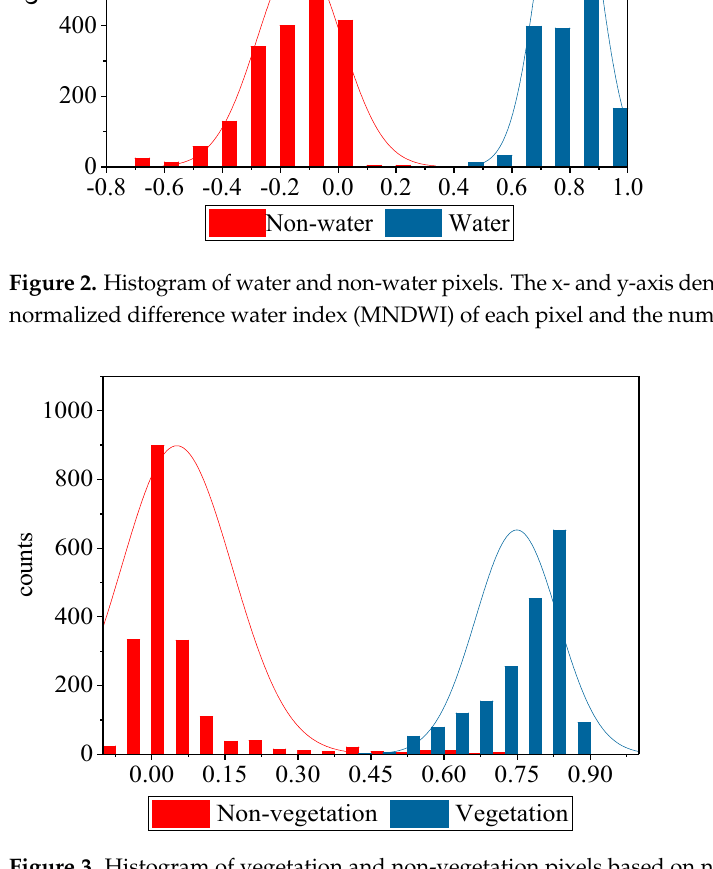
Figure 3. Histogram of vegetation and non-vegetation pixels based on normalized difference vegetation index (NDVI) values.